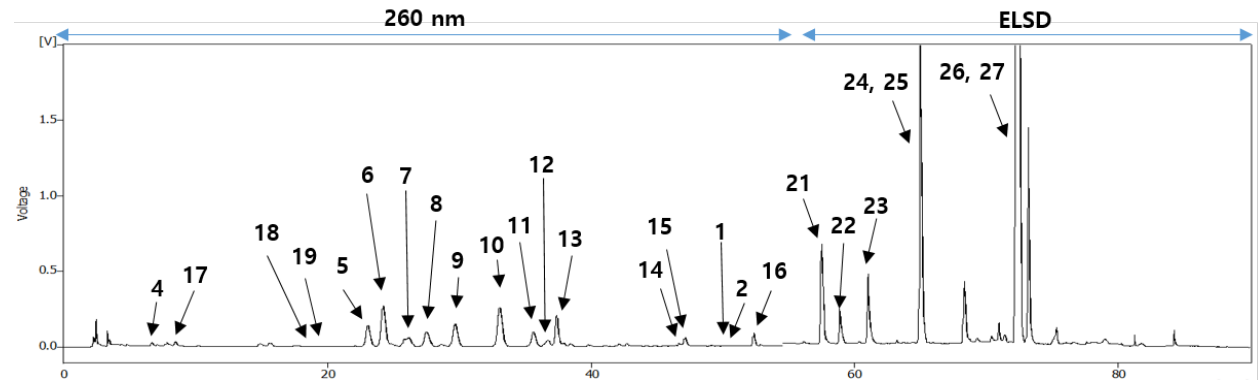
Figure 3. HPLC chromatogram of the EtOH extract from the persimmon leaves.